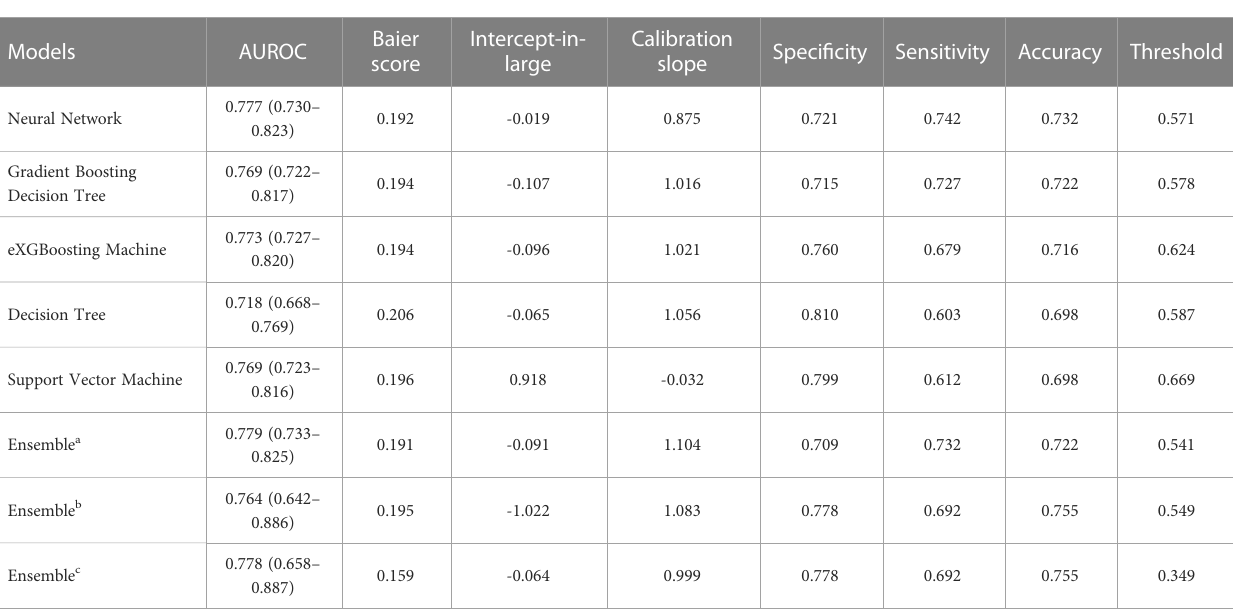
TABLE 5 Key performance indicators of models.